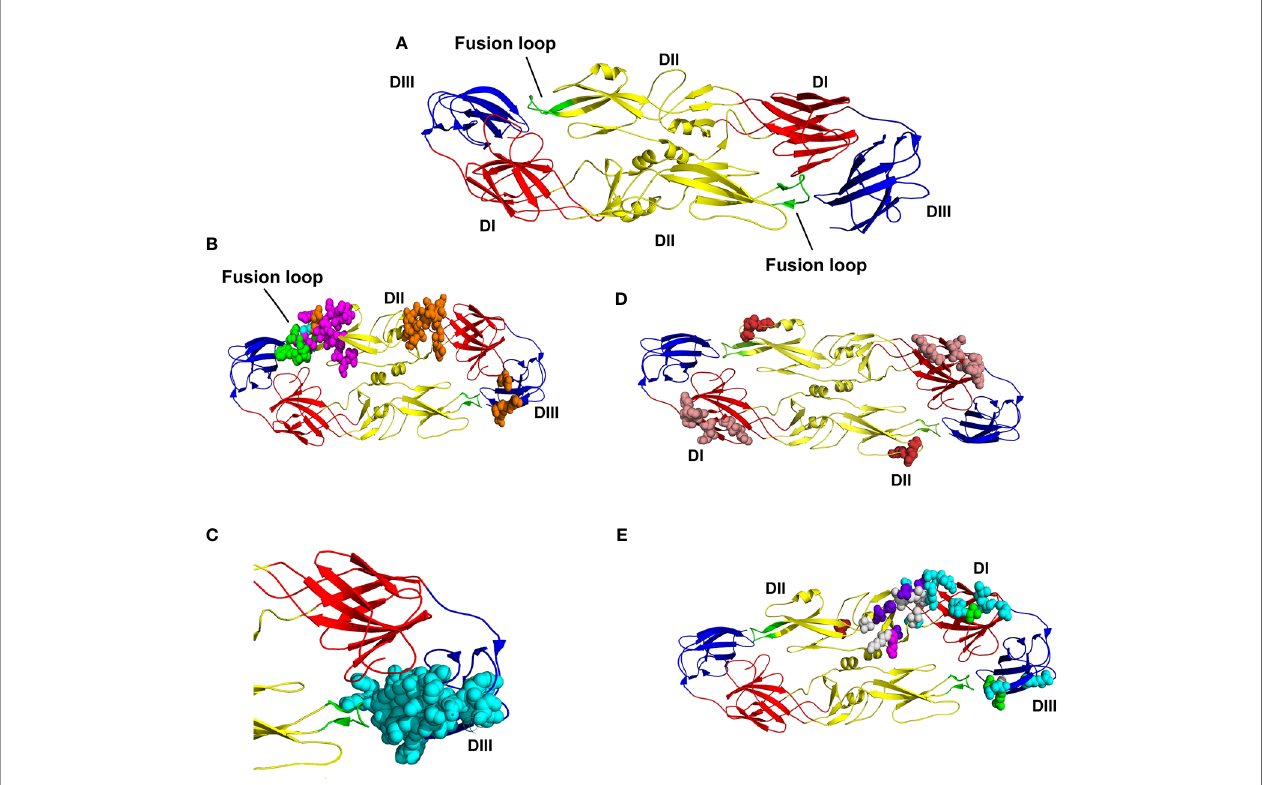
FIGURE 2 | Location B cell epitopes that are the target for neutralizing antibodies and conserved in dengue vaccines on the 3D structure of envelope glycoprotein dimers. (A) 3Dstructureofenvelopeglycoproteindimer.DomainI (DI) isshowninred, Domains II(DII) isshowninyellow,fusionloopisshowningreen,andDomains III(DIII) is showninblue. (B) Locationofthe5 epitopesthatshareresiduesinthe fusionloop, showningreen. Threeoftheseepitopes containalloftheirresidueslocatedinthefusionloop (504078, 504074e 178102). TheepitopeID240773(magenta)alsohasresiduesinDIIandtheepitopeID241577(orange)alsohasepitopesinDIIandDIII.Residuessharedby thesetwoepitopesoutofthefusionloopareshownincyan. (C) NineepitopesshownincyanarelocatedinDIII(IDs540687,540688, 540689,753469, 753470, 504117, 504136, 504134,and504135).Thethreelastepitopeshave residueslocatedatthestemregion;whichwasnotrepresentedinthis3Dmodel. (D) Representationoftheepitope withID753471,withresiduesshowninsalmon. AllresiduesarelocatedatDII. (E) Residuessharedbysix epitopesare showninwhiteandarelocatedindomainsI,II, andIII. The epitopes withresidues locatedintheDIandDIIareshowninbrick(ID591354),green(ID240770),bluish-purple(ID538524) andinmagenta(ID591353). Theepitopewith ID 173906is representedwithresiduesincyan,whicharelocatedinDI,DII,